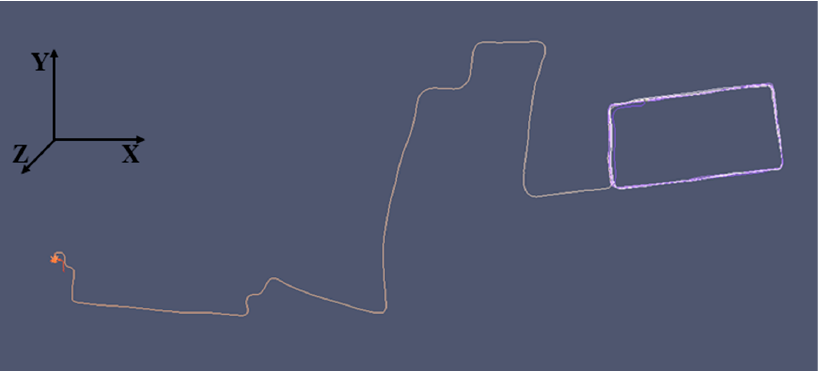
Figure 6. View of GPS position of vehicle.